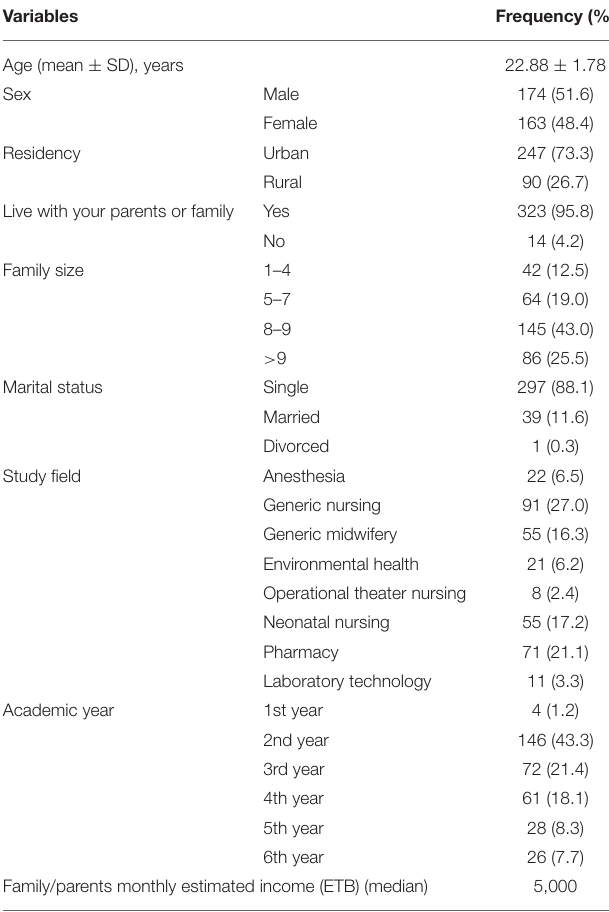
TABLE 1 | Socio-demographic characteristics of the study participants.